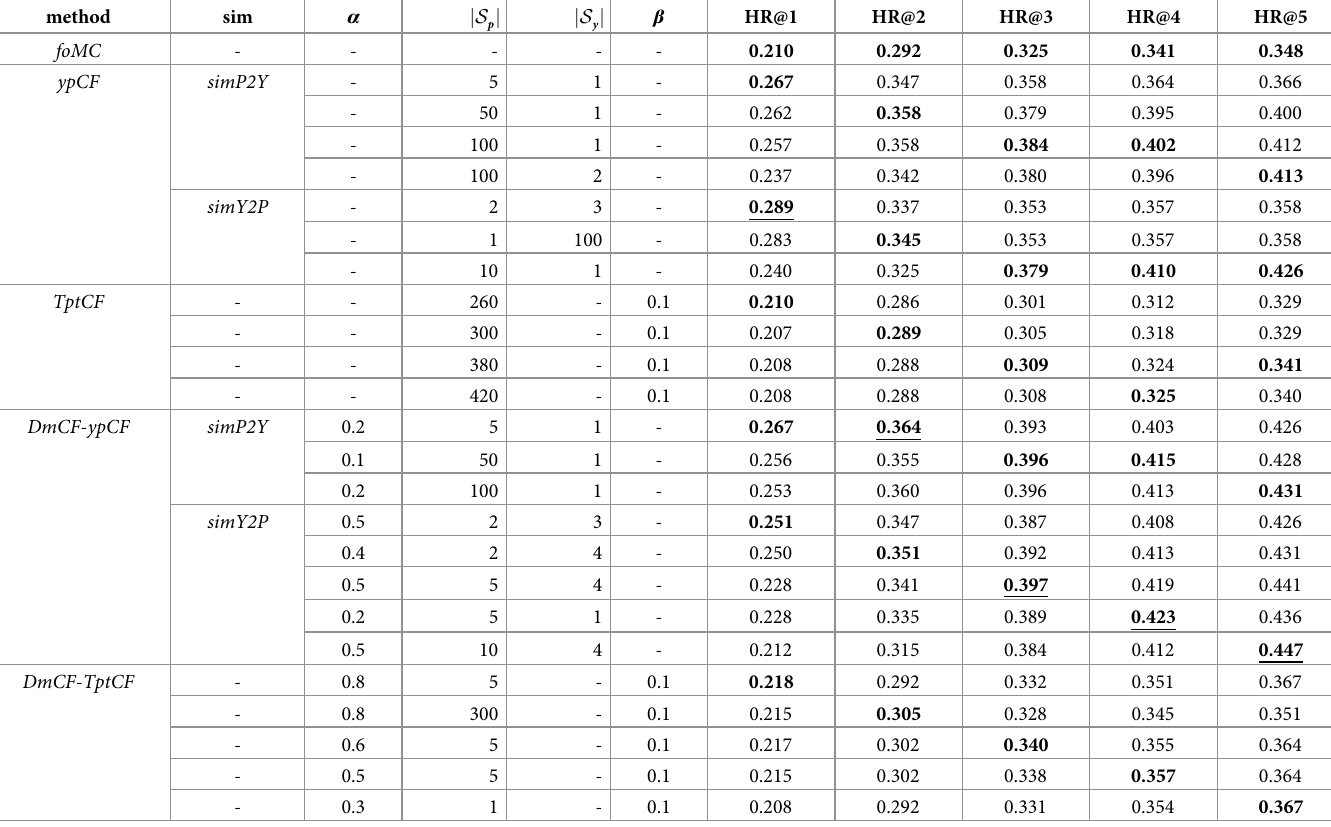
Table 7. Overall performance of all methods for CUTOFF 07/18/2013.